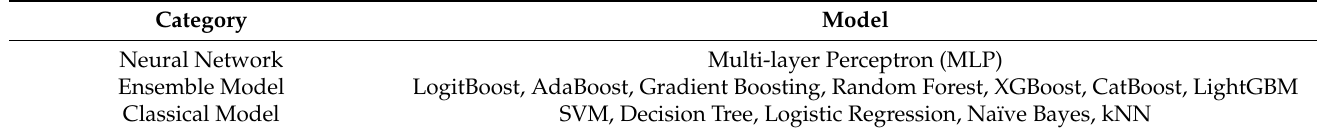
Table 9. Different learning models in the three different supervised machine learning